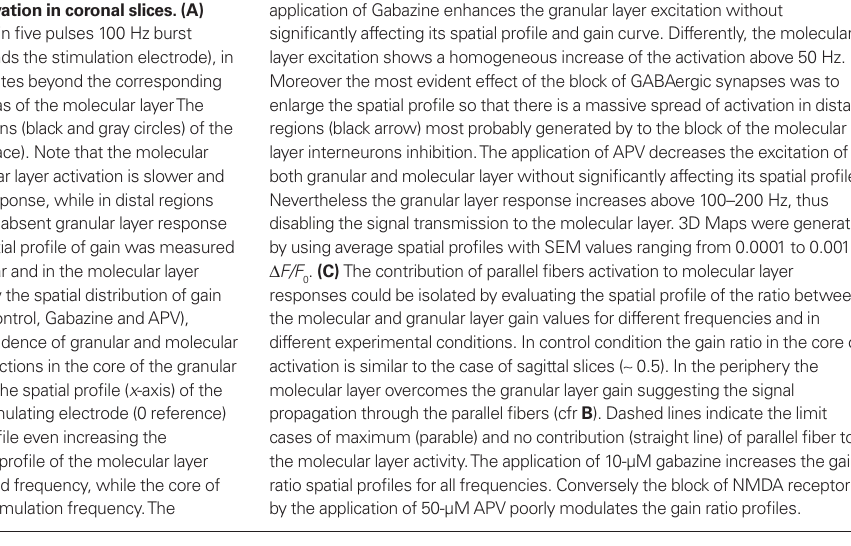
fibers, we used repetitive mossy fiber stimulation in coronal slices ( Figure 7A ). The application of 10–500 Hz bursts activated the granular layer and, as in the case of sagittal slices, signals reached the overlaying molecular layer. Interestingly, the molecular layer